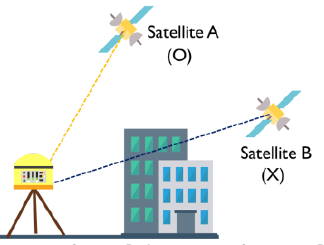
Figure 1. Illustration of signal obstruction from satellite to receiver As in Figure 1, the line between the receiver and Satellite A is